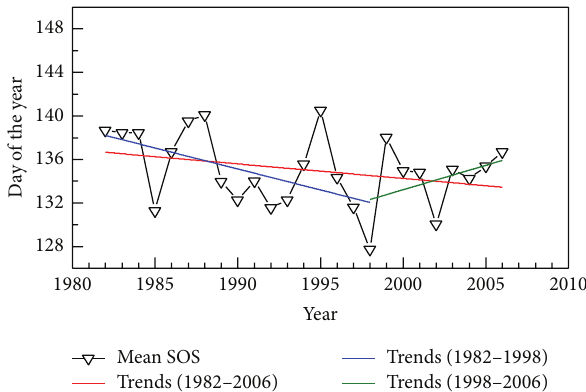
Figure 9: The annual SOS in China’s temperate monsoon area based on the Midpoint method. Regression for the periods 1982–2006, 1982–1998, and 1998–2006 is